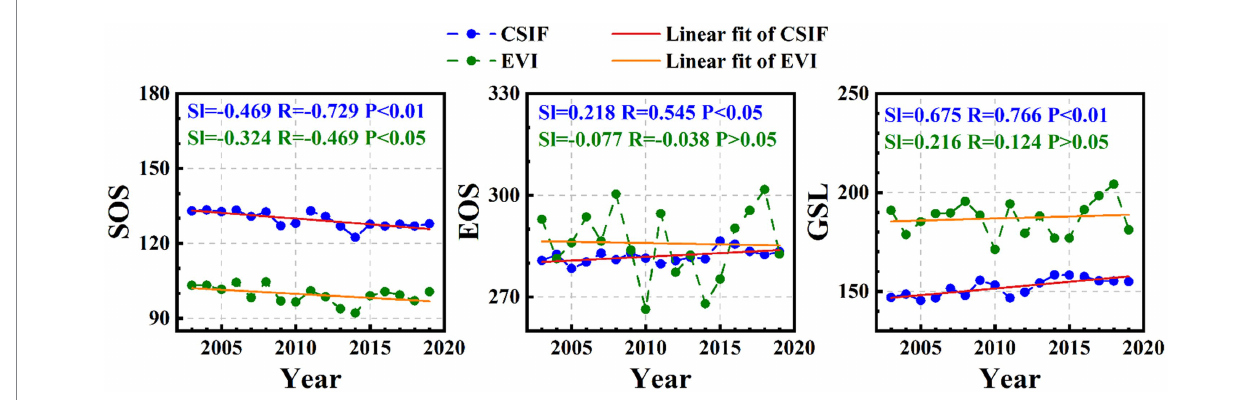
FIGURE 2 Trend of SOS, EOS, and GSL based on DL extraction of CSIF and EVI datasets.